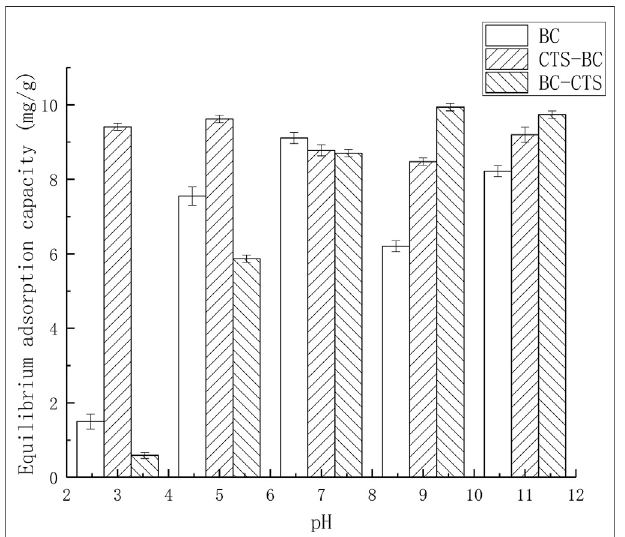
FIGURE 9 | Infrared spectra of the BC,CTS-BC, and BC-CTS before Pb 2+ adsorption https://fanyi.baidu.com/?aldtype (cid:1) 16047 – zh/en/javascript: void